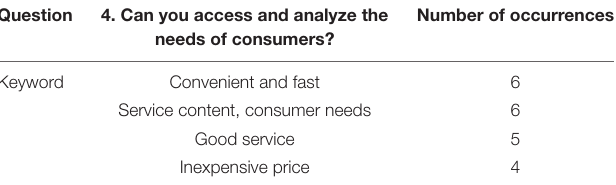
TABLE 6 | Interview results